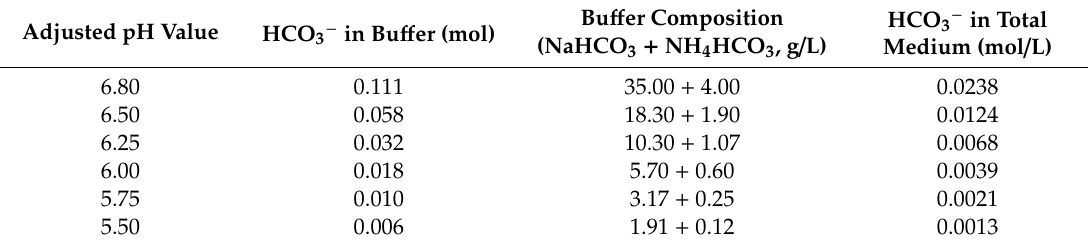
Table 1. Estimated concentration of bicarbonate ion in the incubation solution to fit medium pH to a fixed value and final concentration (mol / L) in the medium for in vitro rumen studies (from calculations by Kohn and Dunlap [32]).